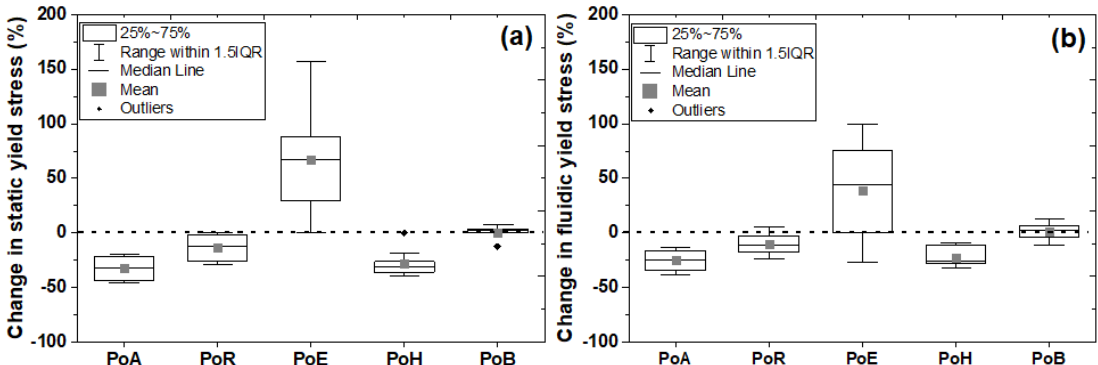
(cid:16) degraded – fresh (cid:17) × 100 of mud × 100(cid:4673) of mud fresh (cid:3033)(cid:3045)(cid:3032)(cid:3046)(cid:3035)